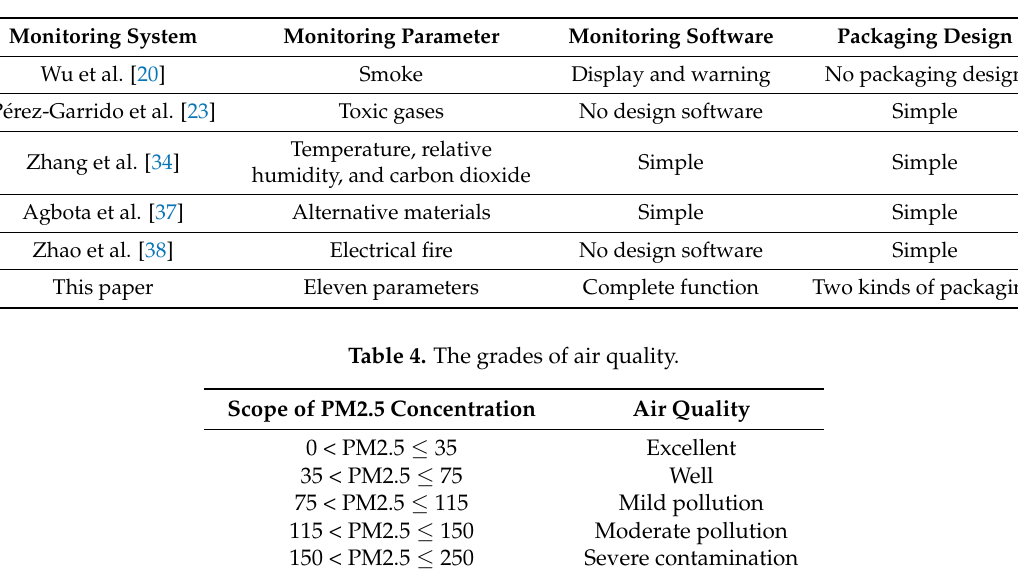
Table 3. The comparison of this monitoring system with other monitoring systems.